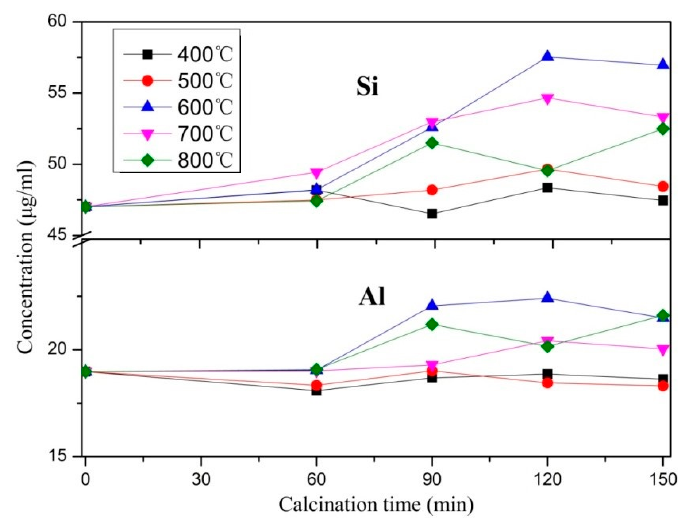
Figure 11. Si and Al concentrations of thermally activated copper tailings after alkali leaching.